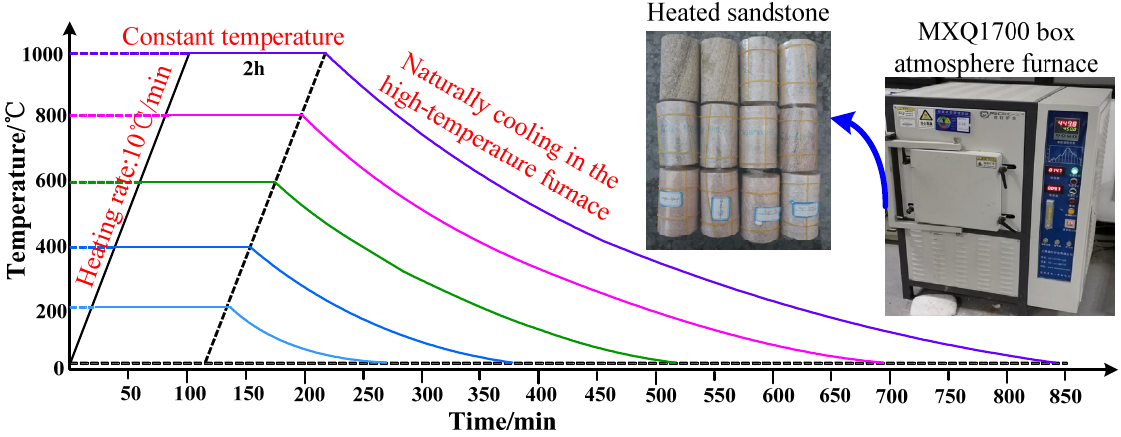
Figure 5. Curves of sandstone samples in the heat treatment.